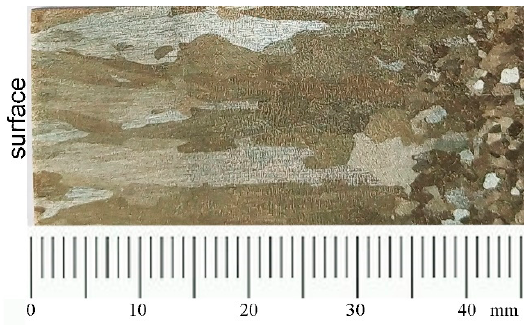
Figure 3. Macrostructure of continuously cast slab.